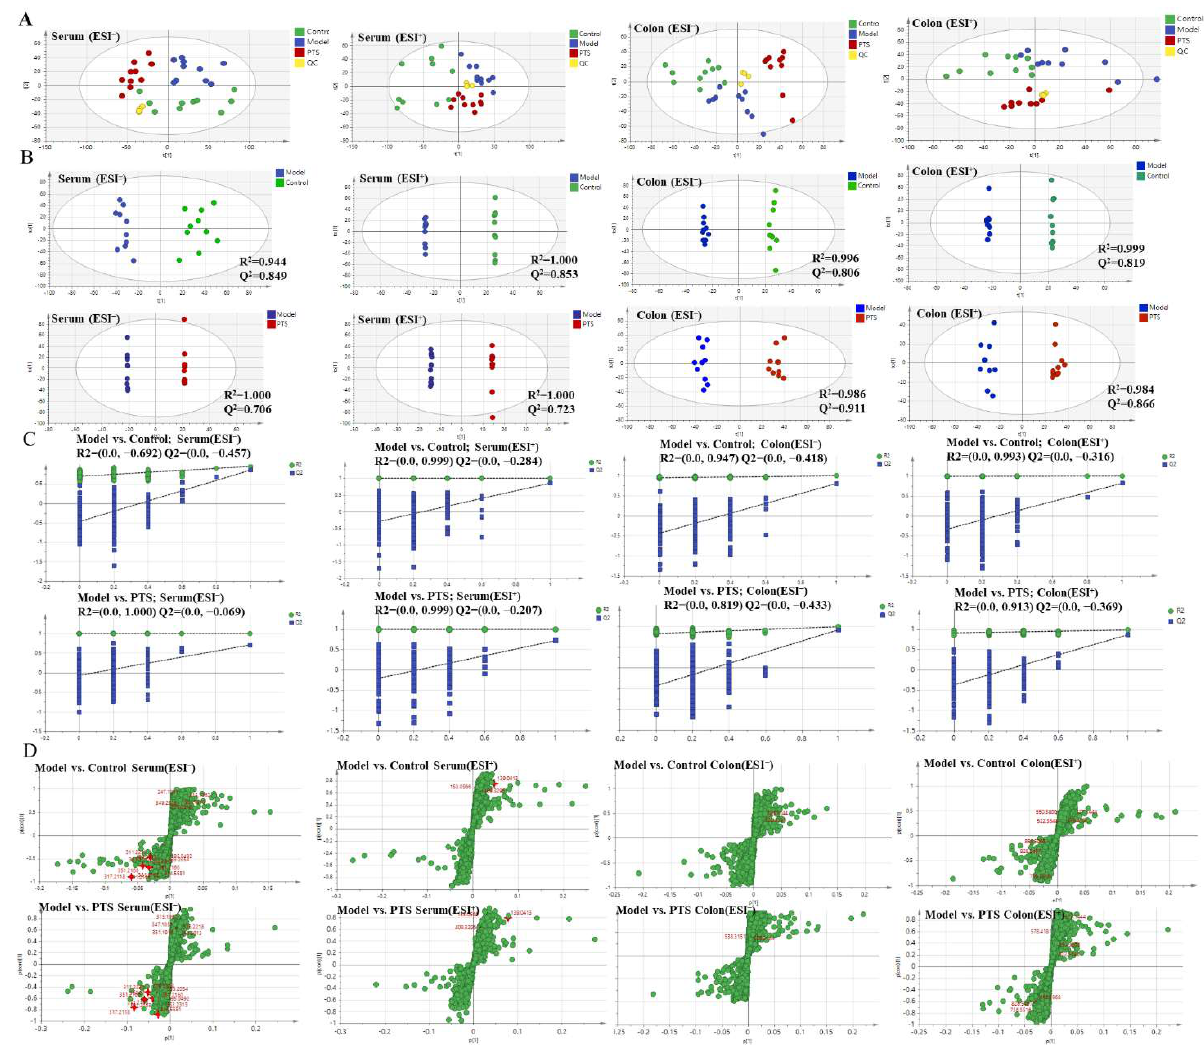
Figure 4. The metabolic profiles of serum and colon were used to calculate the PCA score ( A ), OPLS-DA score ( B ), permutations test plots ( C ), and OPLS-DA S-plots ( D